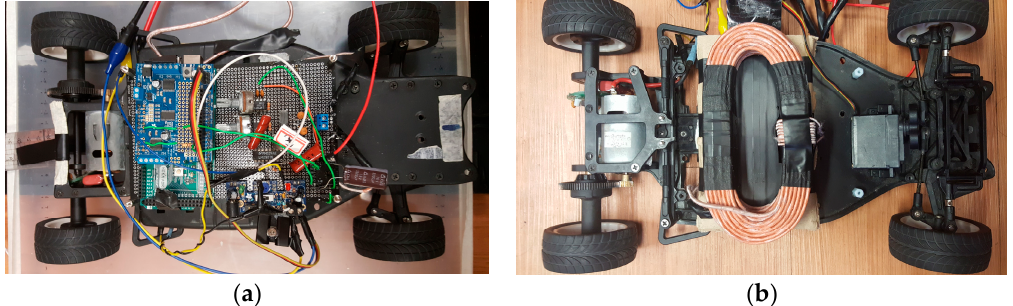
Figure 17. Experimental vehicle. ( a ) Top view, showing the microcontroller unit; ( b ) Bottom view, showing the load coil/sensor coil unit.